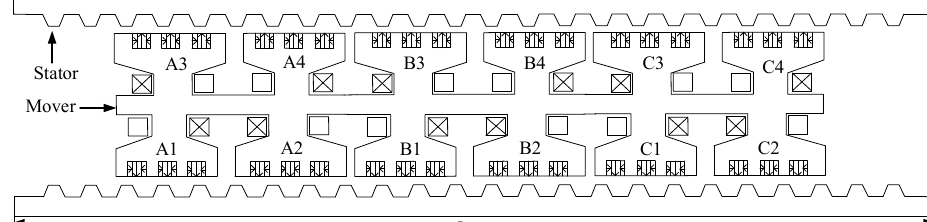
Figure 1. Bilateral linear permanent magnet vernier generator.